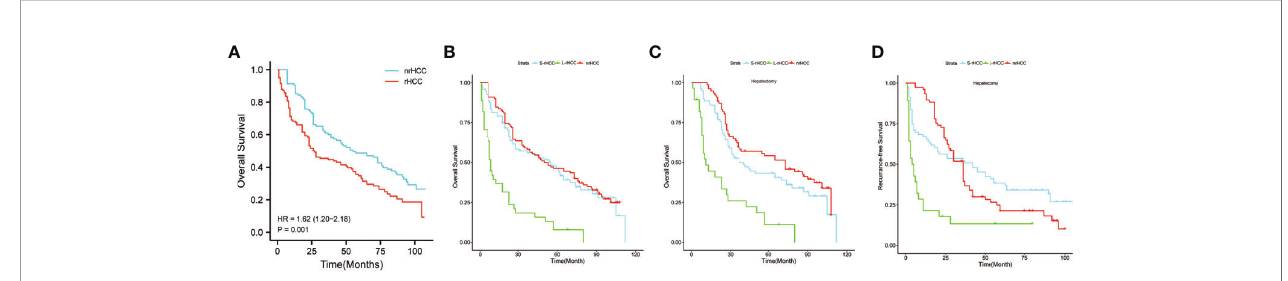
FIGURE 2 | There was a signi fi cant difference in OS between ruptured HCC and non-ruptured HCC patients [HR = (1.62 (1.20 – 2.18), P = 0.001] (A, B) represents all treatment means; (C) represents patients treated with surgery only (OS); (D) represents patients treated with surgery only